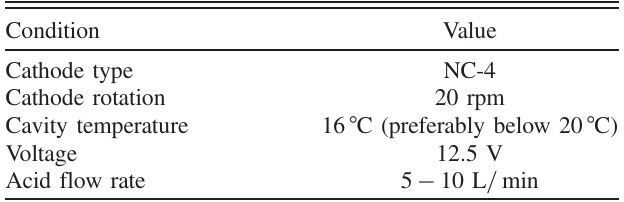
TABLE I. Conditions for VEP conducted for a single-cell coupon